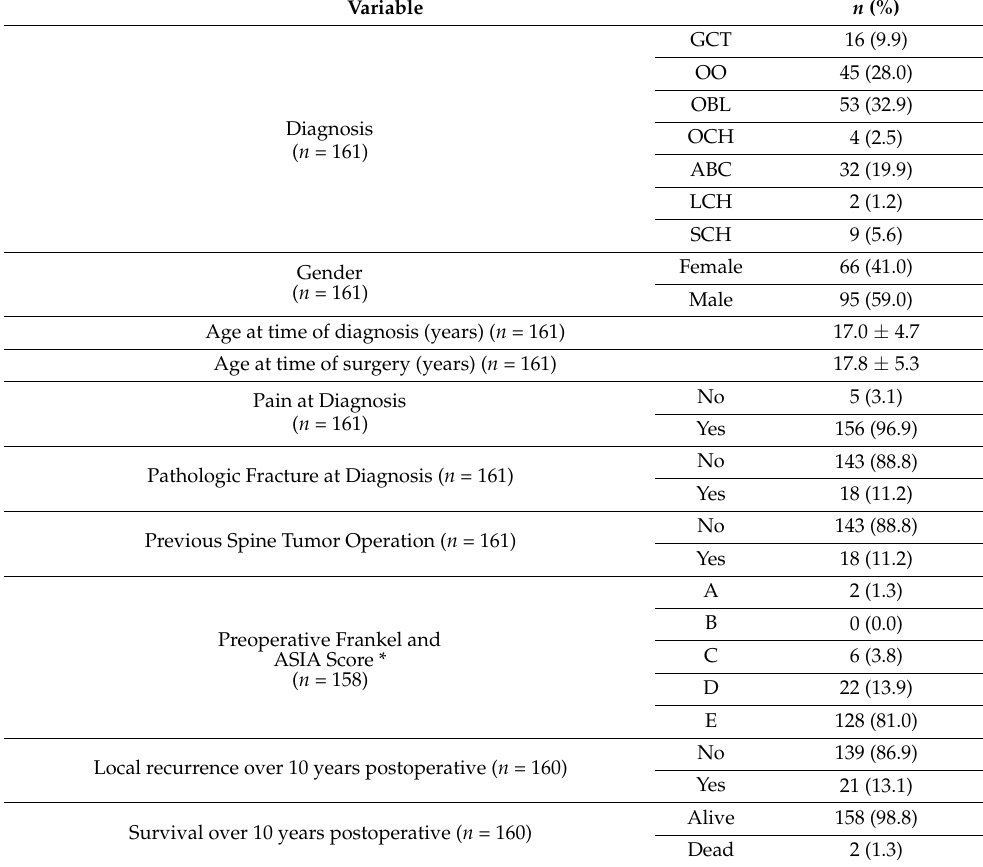
Table 1. Summary of patient demographic and clinical characteristics. Abbreviations are giant cell tumor (GCT), osteoid osteoma (OO), osteoblastoma (OBL), osteochondroma (OCH), aneurysmal bone cyst (ABC), Langerhanns cell histiocytosis (LCH), schwannoma (SCH).